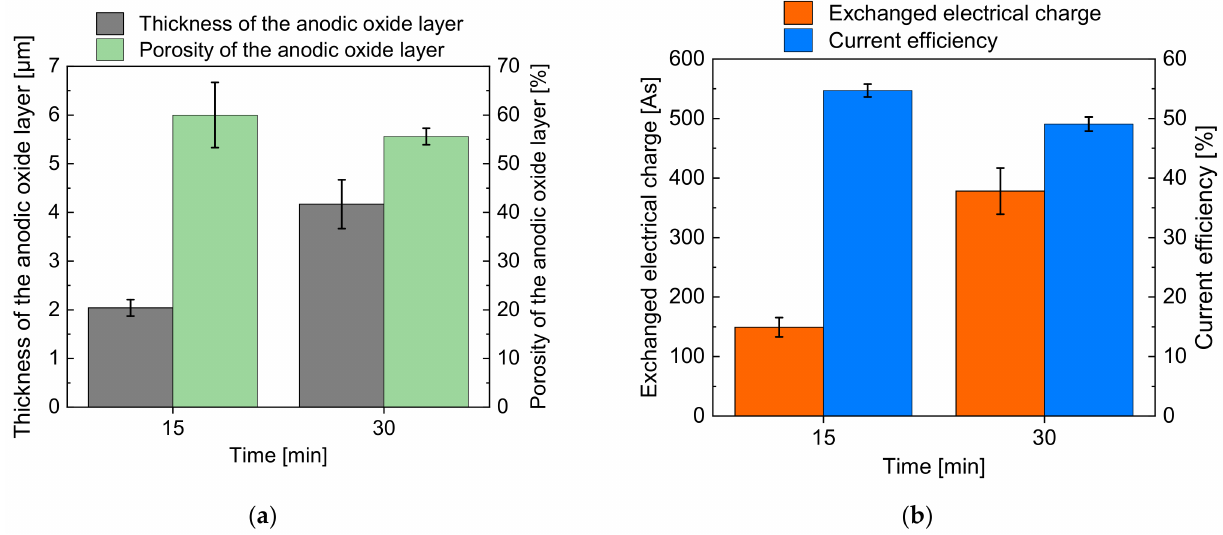
Figure 5. Average values of thickness and porosity of the anodic oxide layer ( a ); exchanged electric charge and current efficiency ( b ) after immersion-based